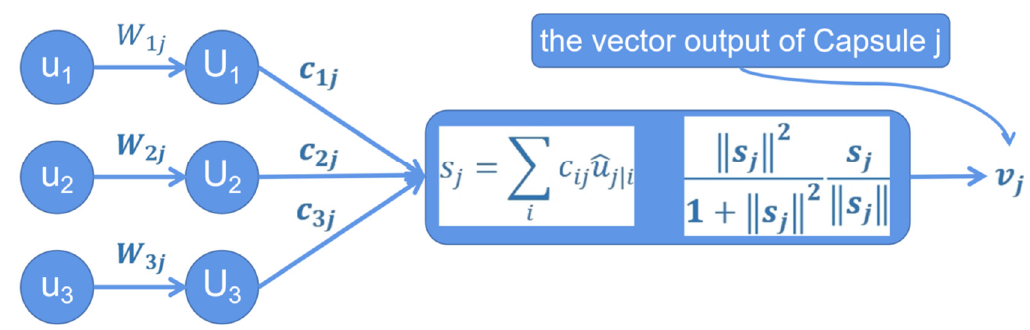
Figure 10. Schematic diagram of neural capsule calculation process.